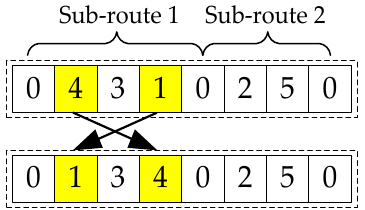
Figure 6. An example of the Exchange Mutation operator.